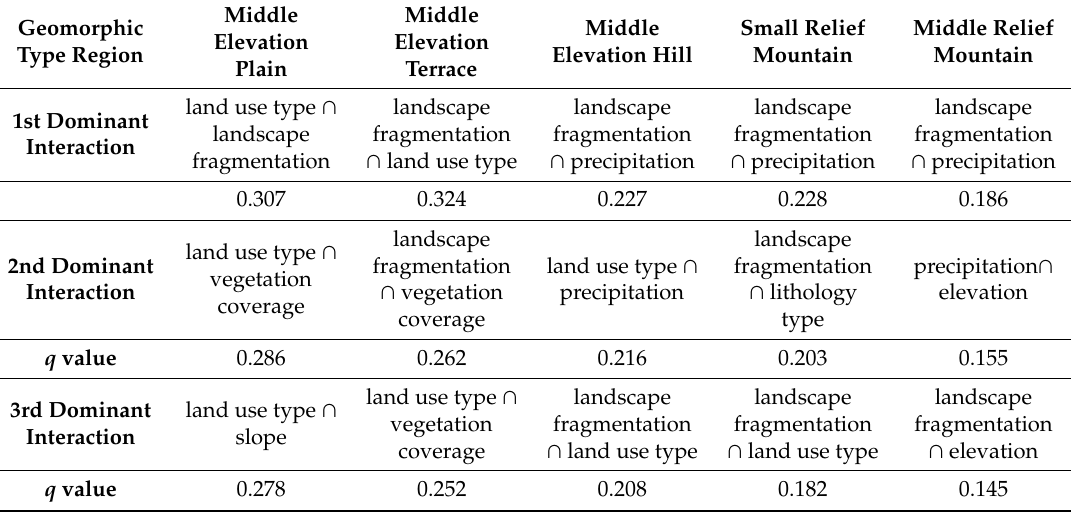
Table 6. The e ff ects of the dominant interactions of two covariates on groundwater for the di ff erent geomorphic